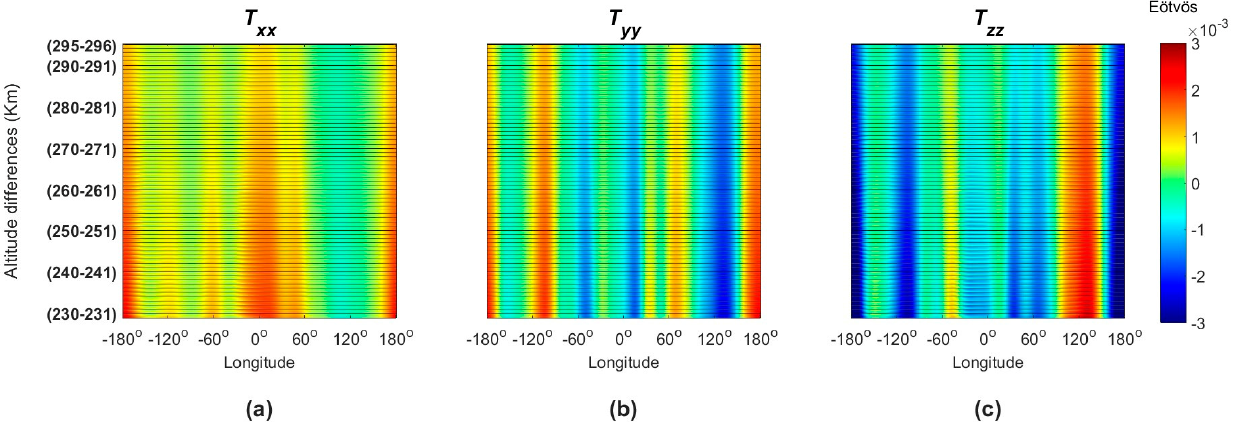
Figure 1. Variation in T ij differences per km of altitude relative for ( a ) T xx , ( b ) T yy and ( c ) T zz gradients. Table 1. Statistics of the T ij differences per km of altitude. Units: (Eötvös). Id km